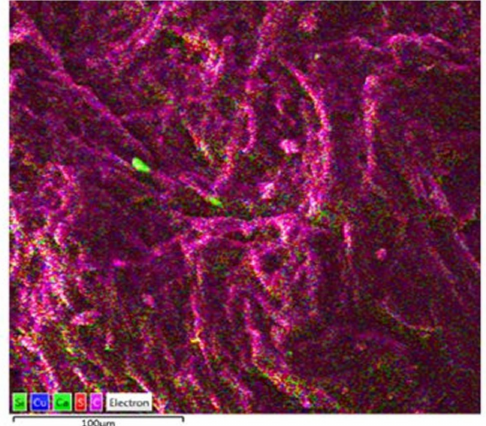
Figure 10. Surface distribution of the identified